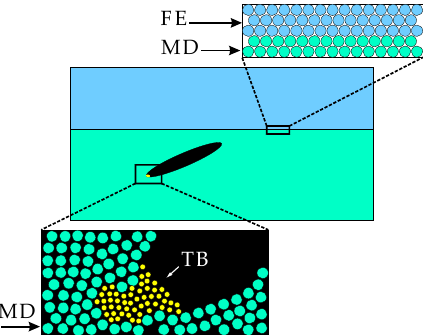
Figure 11. A hybrid FE/MD/TB simulation. The FE, MD, and TB approaches compute forces on particles (either FE nodes or atoms) in their respective domains of application. These forces are then incorporated to calculate the updated positions and velocities of the particles in a time-stepping algorithm. The concurrent approach is best suitable for the systems with an inherent multiscale character.